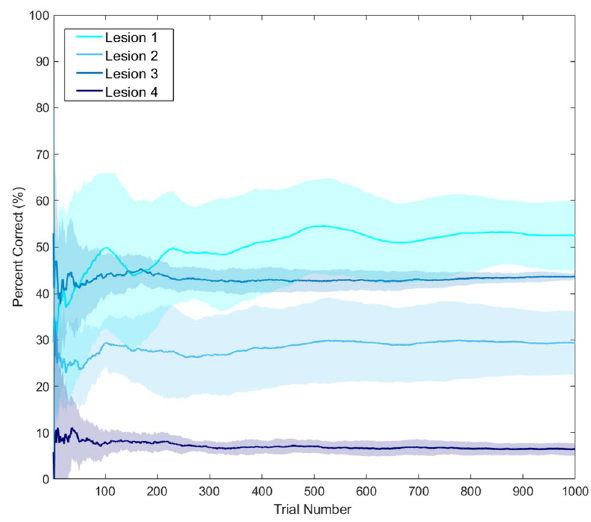
Figure 2. Behavioural performance across 1000 trials. This plot shows the percentage of correct responses for each model across 1000 trials. The x-axis is the trial number, and the y-axis is the cumulative percentage of correct responses (i.e., the percentage of trials that were correct for all trials up to the current trial number). Here, the lines report the average response, and shaded area the 95% confidence intervals, calculated across 10